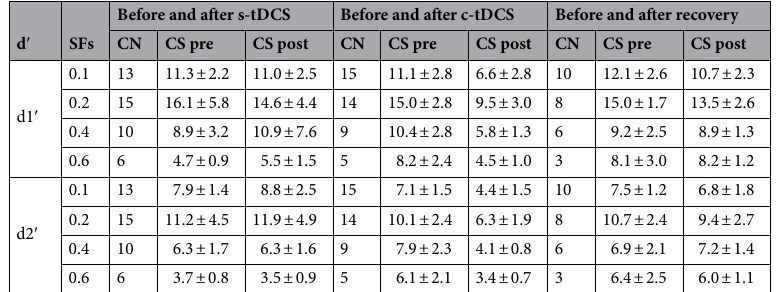
Table 1. The cell number (CN) and the mean contrast sensitivity (CS) value of V1 neurons with different preferred spatial frequencies (SFs) under two performance criteria (70.7% and 79.3%) before and after sham (s)- and cathode c-tDCS in the area 7 as well as some neurons before c-tDCS and after recovery from c-tDCS effect. The CS value is expressed as mean ± SD. SFs is the preferred spatial frequencies (cycle/°) of V1 neurons. Pre and post indicate before and after tDCS,